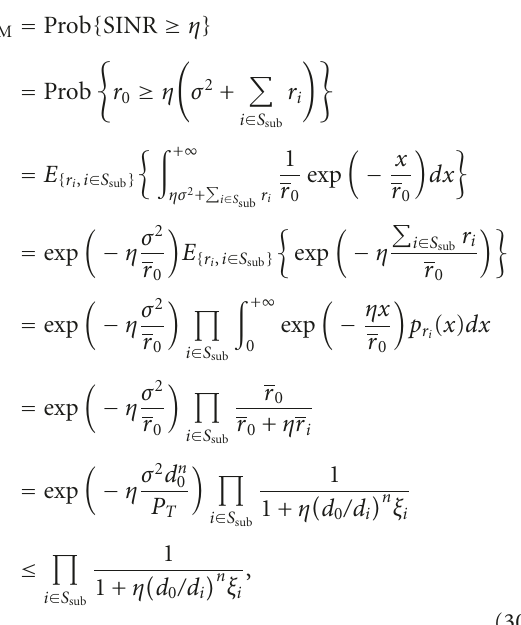
Table 5: Normalized T E2E for networks on the square, hexagonal, and triangular